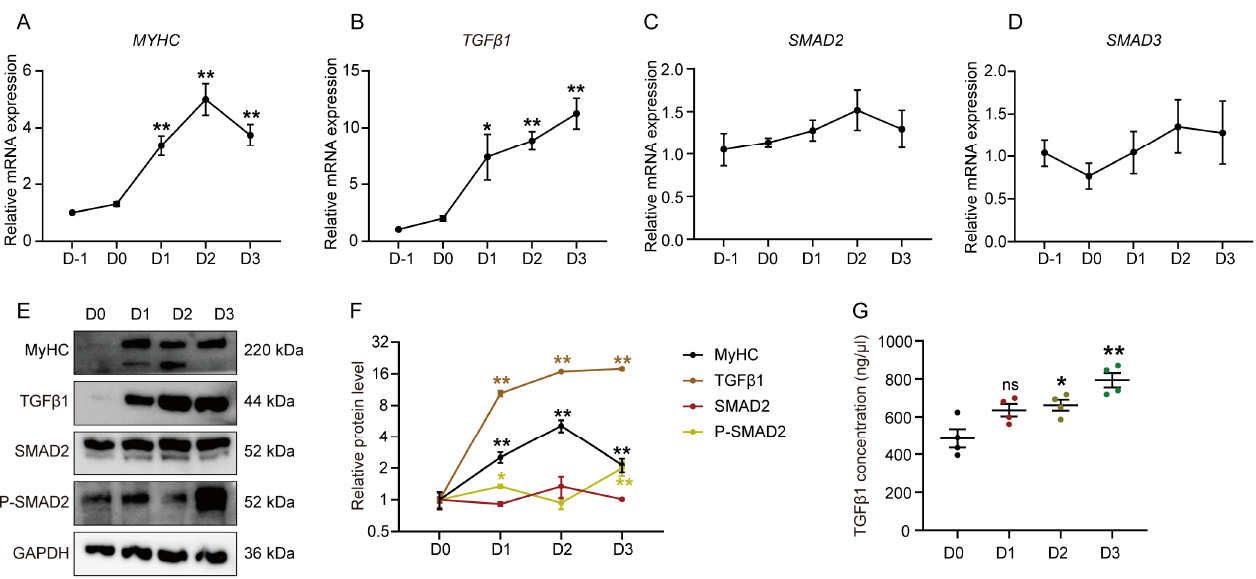
Figure 1. TGF β 1 expression is upregulated during myogenic differentiation. Relative mRNA expression of MyHC ( A ), TGF β 1 ( B ), SMAD2 ( C ), and SMAD3 ( D ), at days -1 (D-1), 0 (confluence [D0]), 1 (D1), 2 (D2), and 3 (D3) of differentiation. Fold changes of these genes are expressed relative to the D-1. ( E ) Western blot analysis of the protein level of MyHC, TGF β 1, SMAD2, and P-SMAD2 on D 0, 1, 2, and 3 during myogenic differentiation of GPMs. ( F ) Quantification of Western blots in ( E ). Fold change of these proteins are expressed relative to the D0. ( G ) TGF β 1 concentration in culture medium of GPMs at D 0, 1, 2, and 3 of differentiation, analyzed using ELISA. The data were obtained from at least three independent experiments. Results are expressed as mean ±SEM; * p < 0.05, ** p < 0.01, ns indicates p > 0.05.